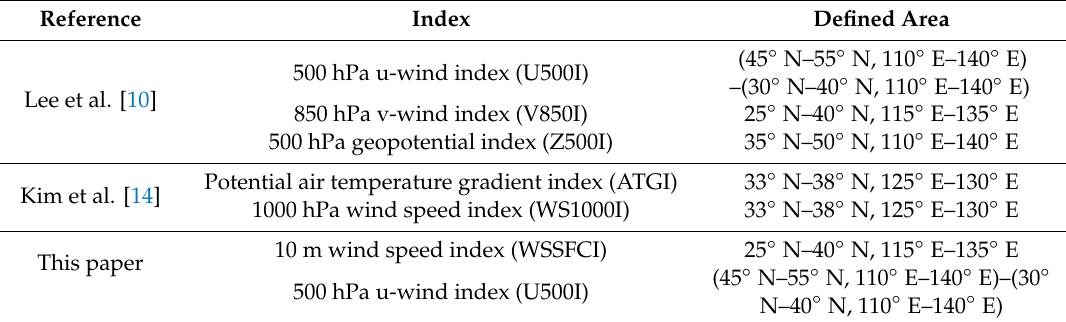
Table 1. The indices and definitions of the 6 indices used in the study.